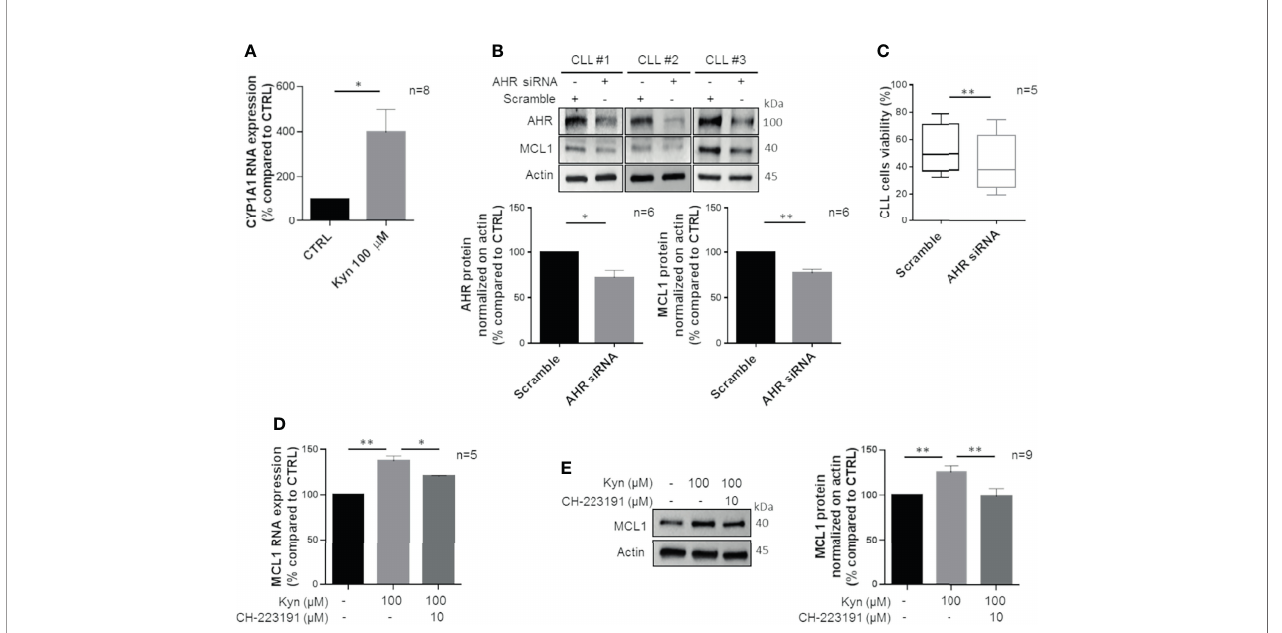
FIGURE 4 | Kyn enhances MCL1 levels by activating AHR. (A) Bar diagram displays CYP1A1 mRNA levels that were measured by real-time PCR in CD19 + cells treated with 100 m M Kyn, for 3 h (Student paired t test, *p < 0.05; n = 8). (B) Immunoblots show expression of AHR and MCL1 48 h after transfection with scramble or AHR siRNA in 3 representative CLL samples. Histograms show densitometric quanti fi cation of AHR and MCL1 protein level (Student paired t test, *p < 0.05, **p < 0.01; n = 6). (C) Box plots represent the percentage of viable CLL cells after 48h from transfection with AHR siRNA or scramble (Student paired t test, **p < 0.01; n = 5). (D) MCL1 mRNA levels were measured by real-time PCR in CLL cells pretreated for 90 min with 10 µM CH-223191 prior to addition of 100 µM Kyn. Histogram depicts the inhibition of MCL1 induction by CH-223191 (Student paired t test, *p < 0.05, **p < 0.01; n = 5). (E) Immunoblot depicts MCL1 protein levels in a representative case. On the right, histogram represents the